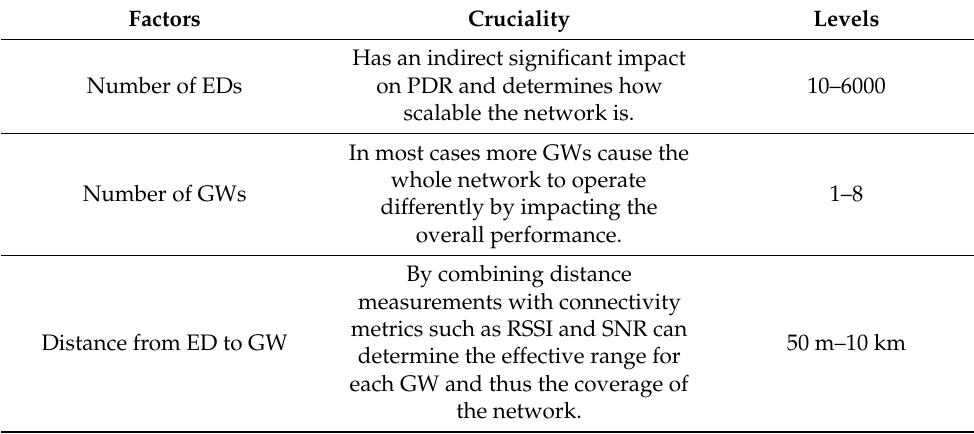
Table 1. Crucial factors to control and